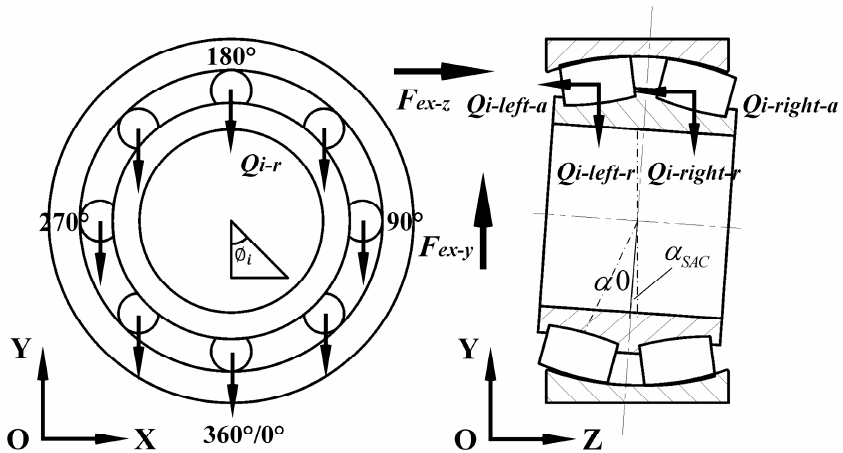
Figure 2. SRB schematic under global coordinate. SRBs’ self-aligning process is only emerging in the YOZ plane. Plus (+) means self- aligning clockwise, and minus ( − ) indicates an anticlockwise self-aligning process. The contact between bearing components only occurs locally, and the contact parts are isotropic and uniform